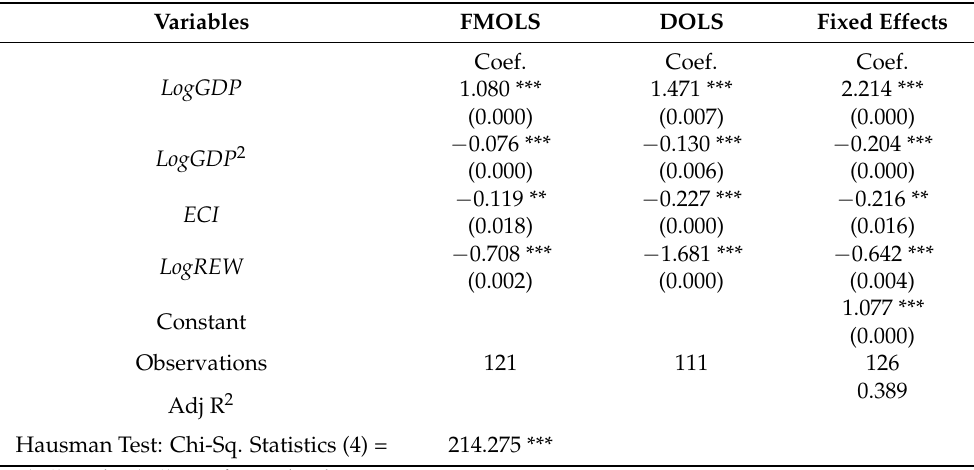
Table 6. Panel Fully Modified Least Squares (FMOLS), Panel Dynamic Least Squared (DOLS), and Fixed Effects